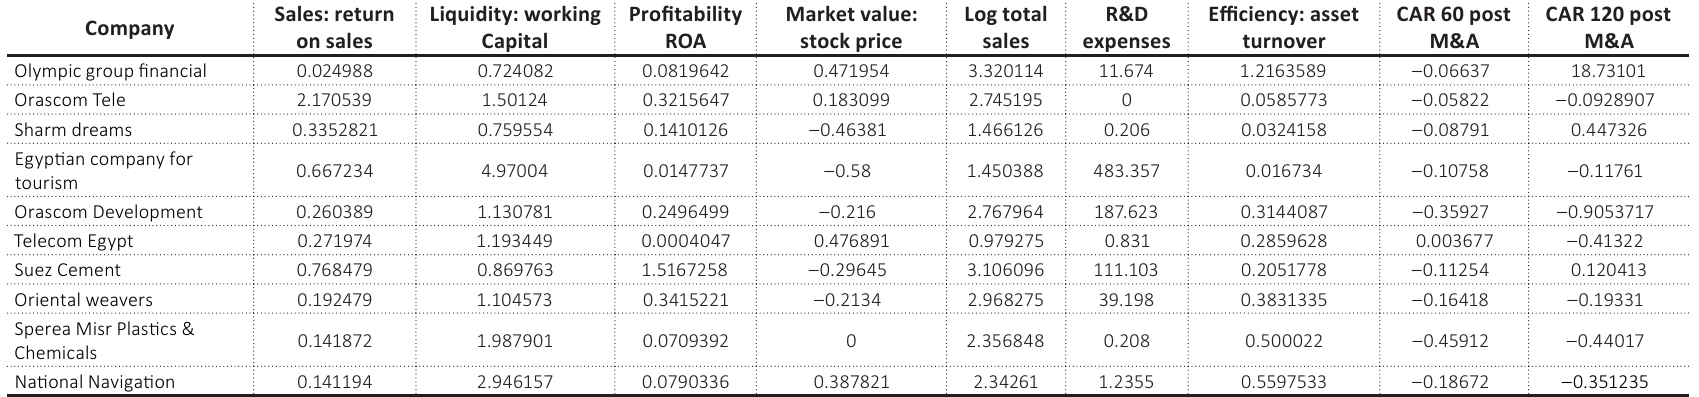
Table E1. Results for BSC and CAR